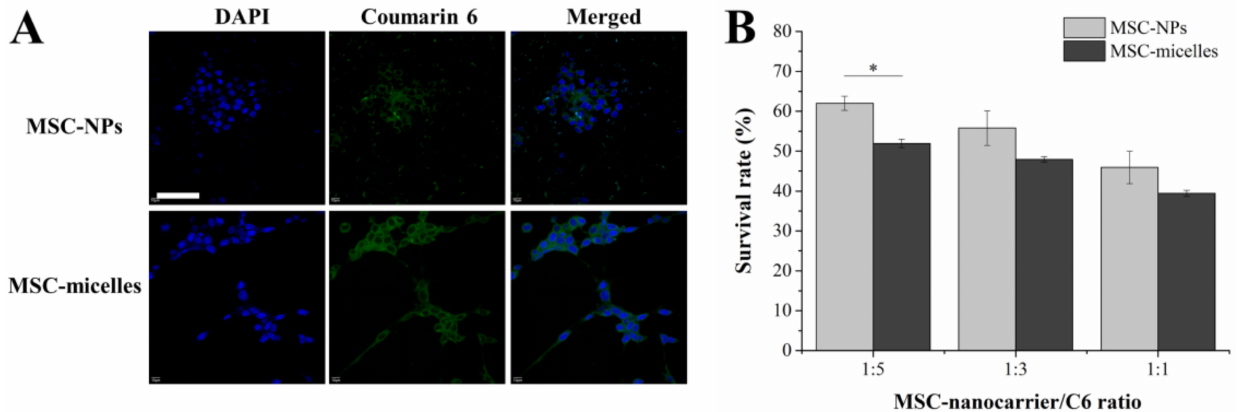
Figure 5. ( A ) CLSM images of C6 cells seeded in the bottom chamber while MSC-nanocarriers loaded with coumarin 6 were seeded in the upper chamber. The nuclei were stained with DAPI (bar = 50 µ m). ( B ) Antitumor effects of MSC-micelles against C6 cells with different cell number ratios in the transwell system (* p <